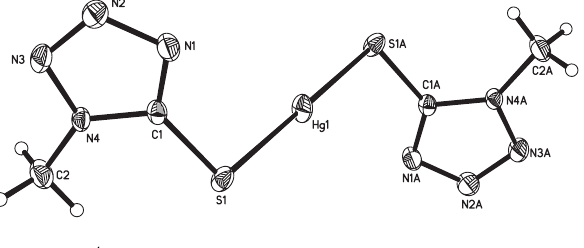
Table 1: Data collection and handling.